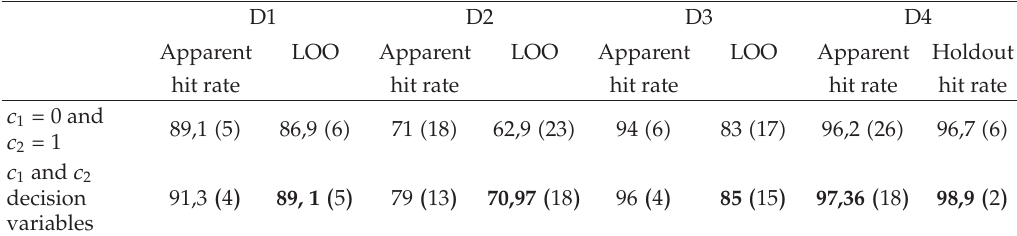
Table 4: The apparent, the LOO, and the holdout hit rates (cid:2) in percentage (cid:3) of the RS model. D1 D2 D3 D4 Apparent LOO Apparent LOO Apparent LOO Apparent Holdout hit rate hit rate hit rate hit rate